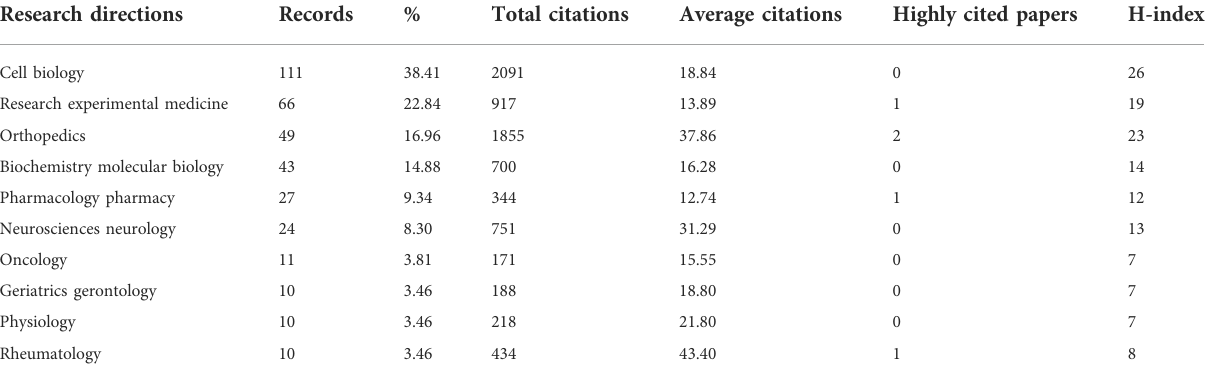
TABLE 3 Top 10 research directions with the most publications on oxidative stress in intervertebral disc degeneration from 2007 to 2021. Research